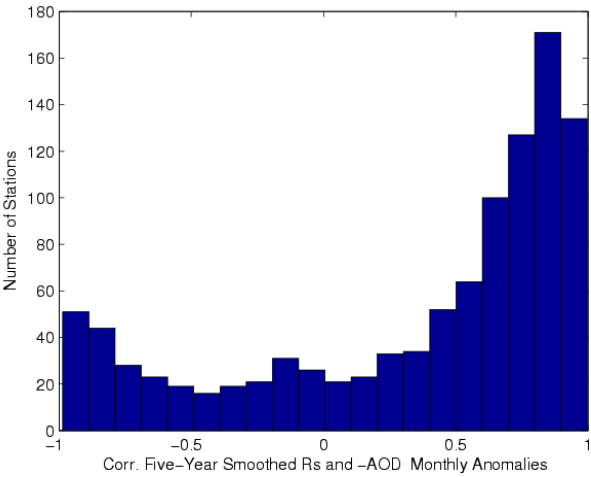
Fig. 11. The histogram of correlations between the five-year smoothed R s and -AOD monthly anomalies at each station. The five-year (60-month) smoothing filters out high frequency variations in R s and -AOD (shown in Fig. 9). About 58% of all stations have a correlation coefficient larger than 0.5. Such correlation coefficients indicate that the decadal variation in aerosols control the decadal variation in R s (Fig. 9).